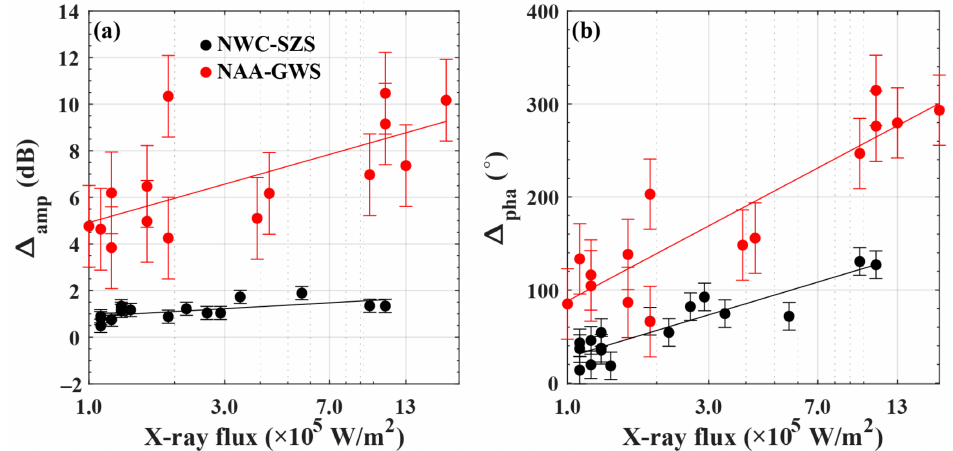
Figure 4. The amplitude and phase variation versus the X-ray fluxes caused by the solar flare class, as well as fitting functions for the VLF signals (black for NWC-SZS and red for